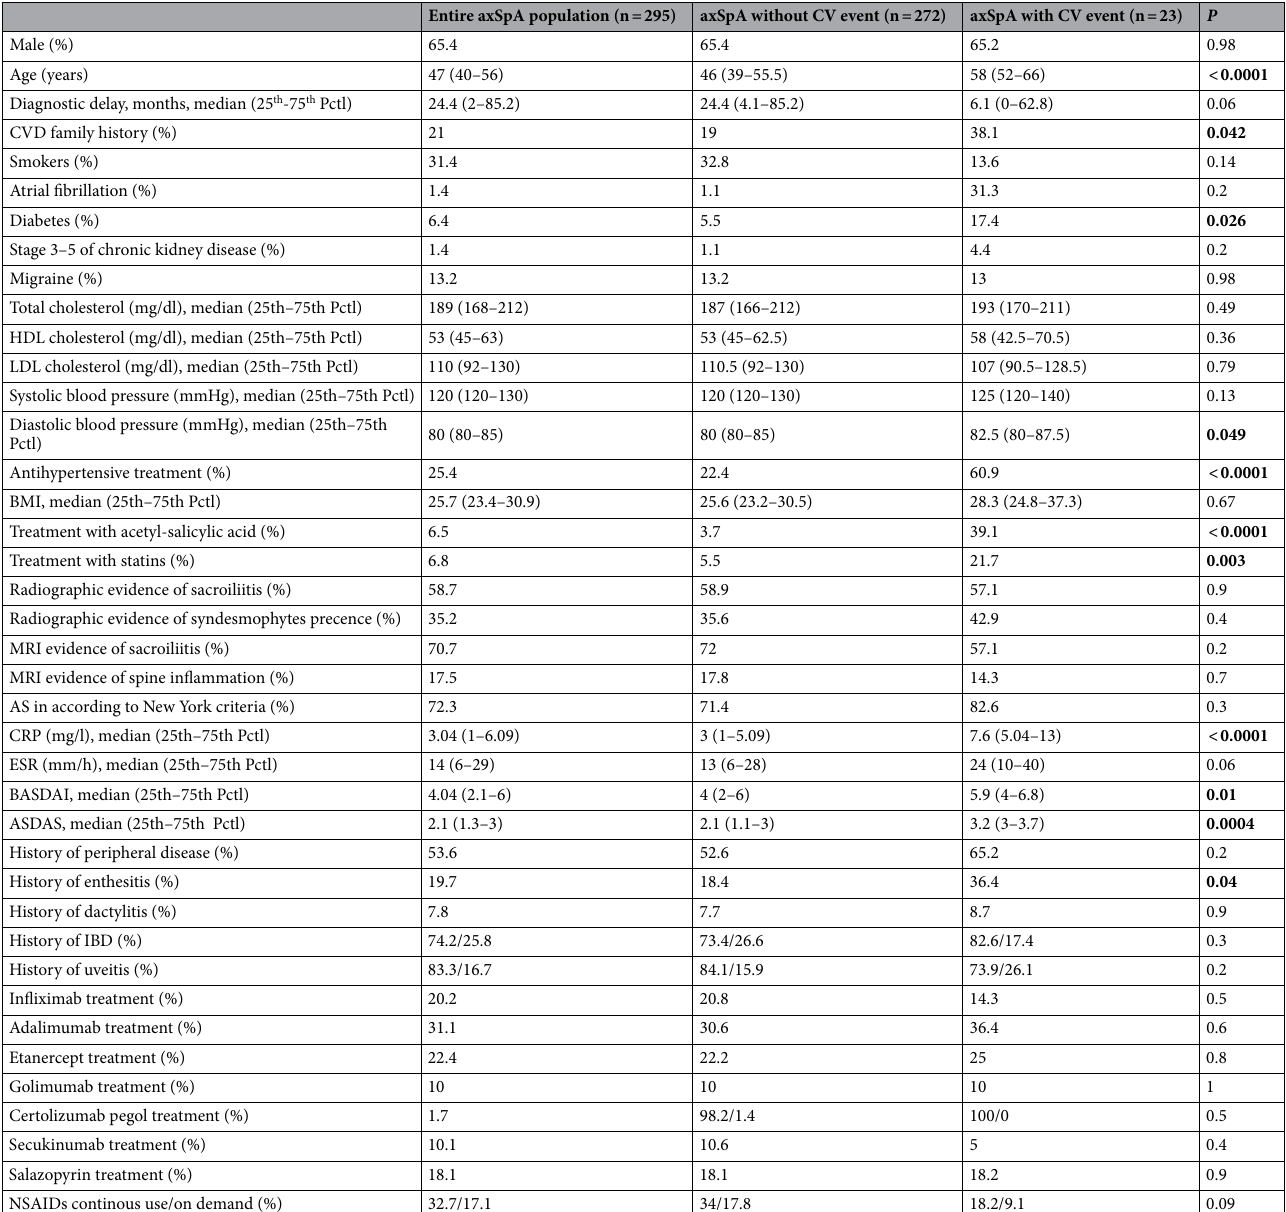
Table 1. Demographic and clinical characteristics of the patients. axSpA axial spondyloarthritis; CV cardiovascular; Pctl percentile; CVD cardiovascular disease; BMI body mass index; MRI magnetic